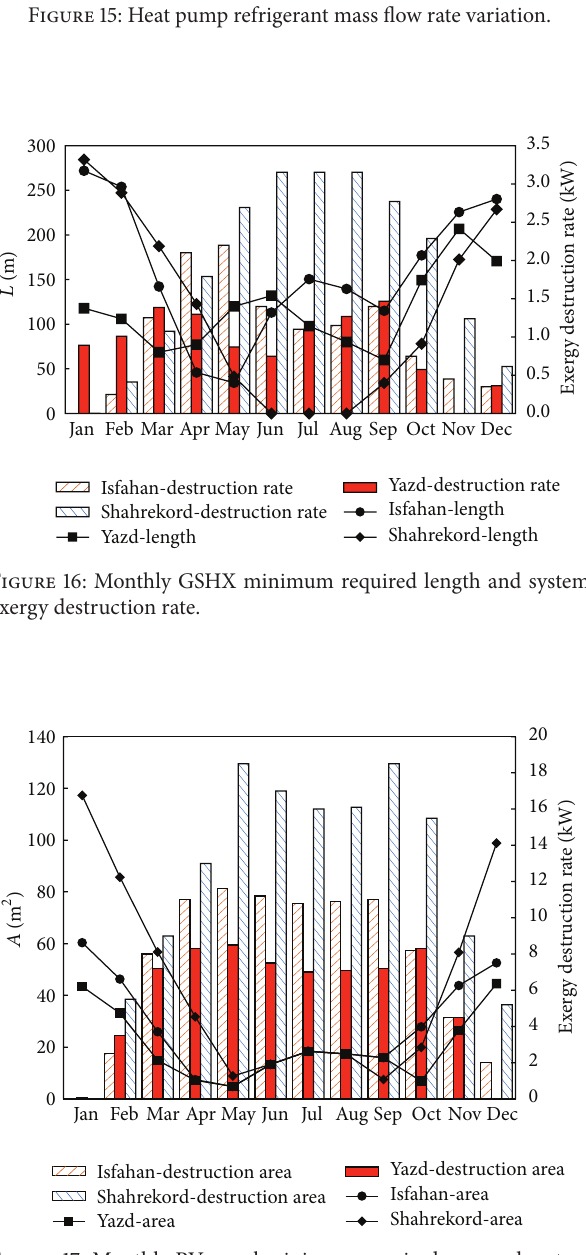
Figure 14: PV panel minimum required area for each month.